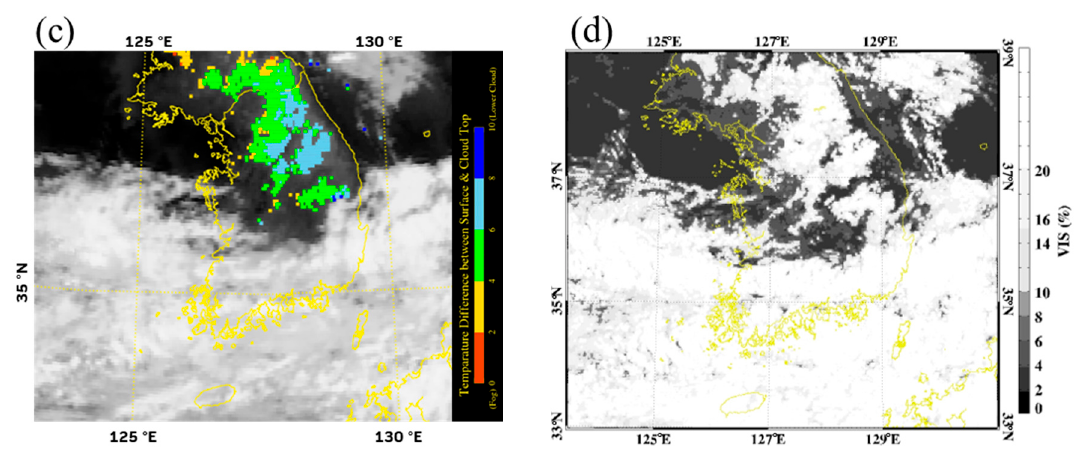
Figure 8. Sample image of fog detection results at 08:00 KST on 25 August 2019. ( a ) Fog image of GK2A_FDA, ( b ) ground-observed visibility, ( c ) fog image of CMDPS, and ( d ) image of visible channel (0.64 µ m). Sky blue color in ( a ) indicates foggy pixels.